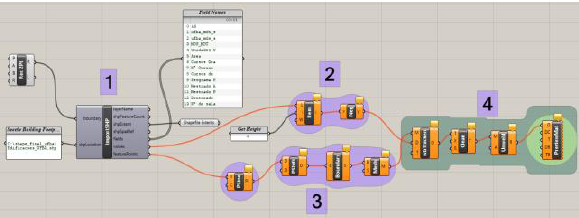
Figure 12: Importing the shapefile archive and geometric modeling methodology